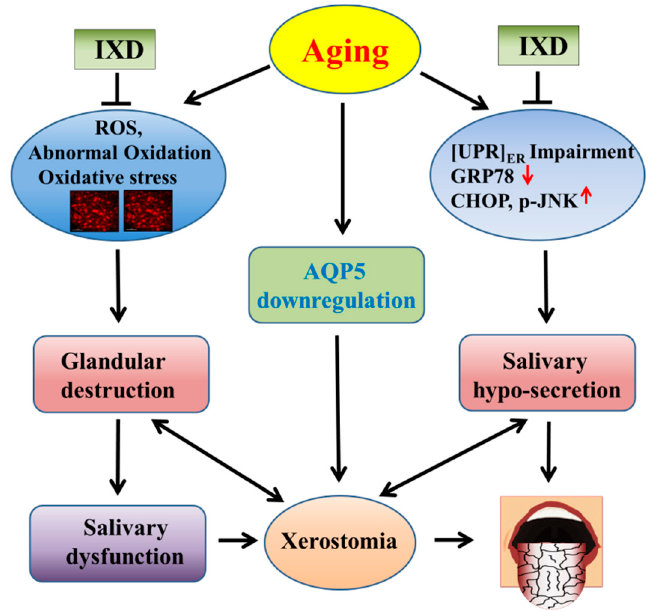
Figure 9. The proposed mechanism of an IXD extract against aging-triggered dry mouth. This graphic representation shows the mechanism of aging-induced xerostomia and the application of IXD extract against aging-associated dry mouth syndrome. This figure shows the aging-associated abnormal oxidation of proteins, increased oxidative stress, impairment of the UPR components (decreased GRP78 and increased CHOP and JNK), decreased water channel protein AQP5, leading to salivary gland destruction and hypo-secretion. This may cause salivary gland dysfunction and deters salivary flow leading to dry mouth syndrome. The graphic shows that IXD extract has a potential to regulate aging-associated ER stress and oxidative stress, increase AQP5, increase salivary secretion and comfort from xerostomia.